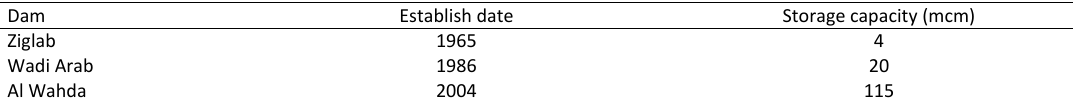
Table 5: Establishment date and storage capacity of the study area dams